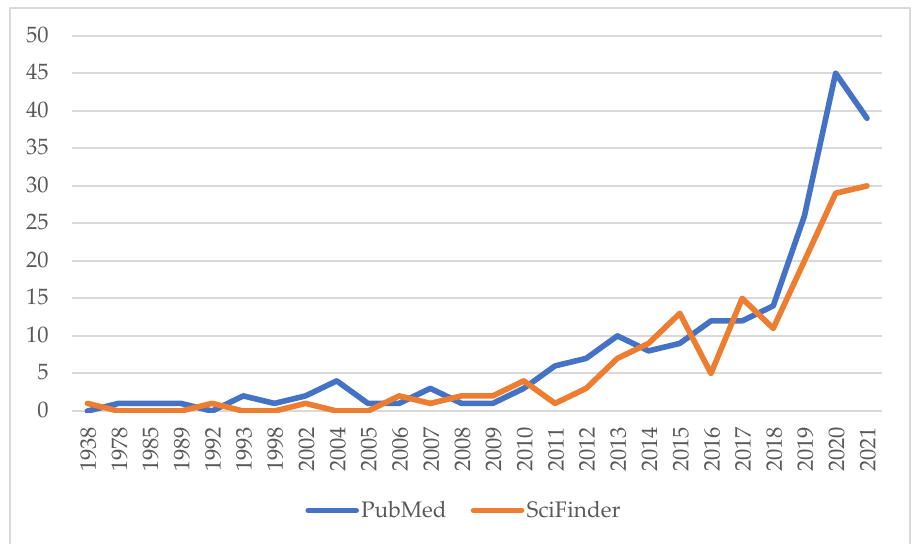
Figure 2. Scientific publications 1938–2021 on coffee by-products. Sources: PubMed, National Library of Medicine, Bethesda, MD, USA; SciFinder n , CAS, American Chemical Society (ACS), Columbus, OH, USA. Search term: “coffee by-product” OR “coffee byproduct”, searches conducted 17 December 2021.